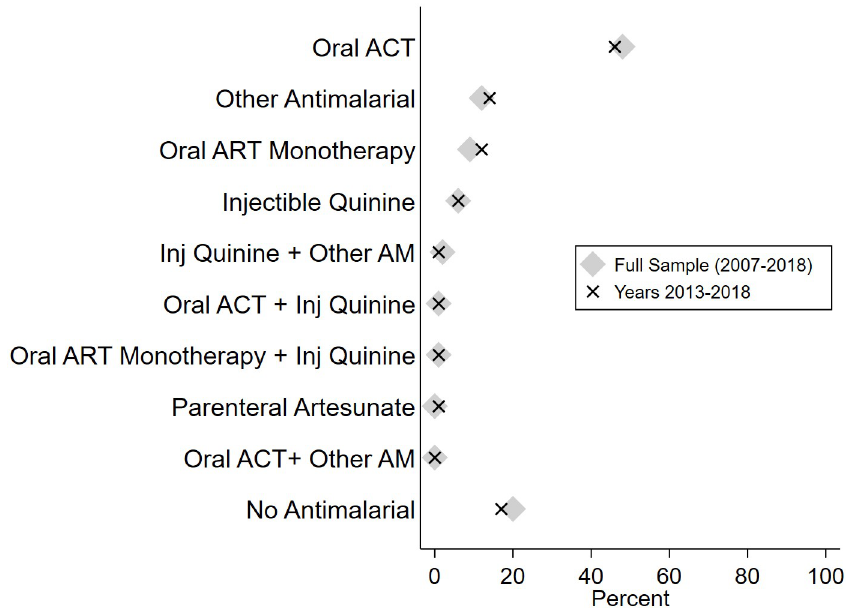
Fig 2. AM prescriptions among children diagnosed with malaria. “Other AM” includes chloroquine, sulfadoxine- pyremethamine, amodiaquine, quinine, and a few other very infrequently prescribed types of AMs not specified in the survey tool. Data are weighted using SPA-provided survey weights. ACT, Artemisinin Combination Therapy; AM, antimalarial; ART, artemisinin; SPA, Service Provision